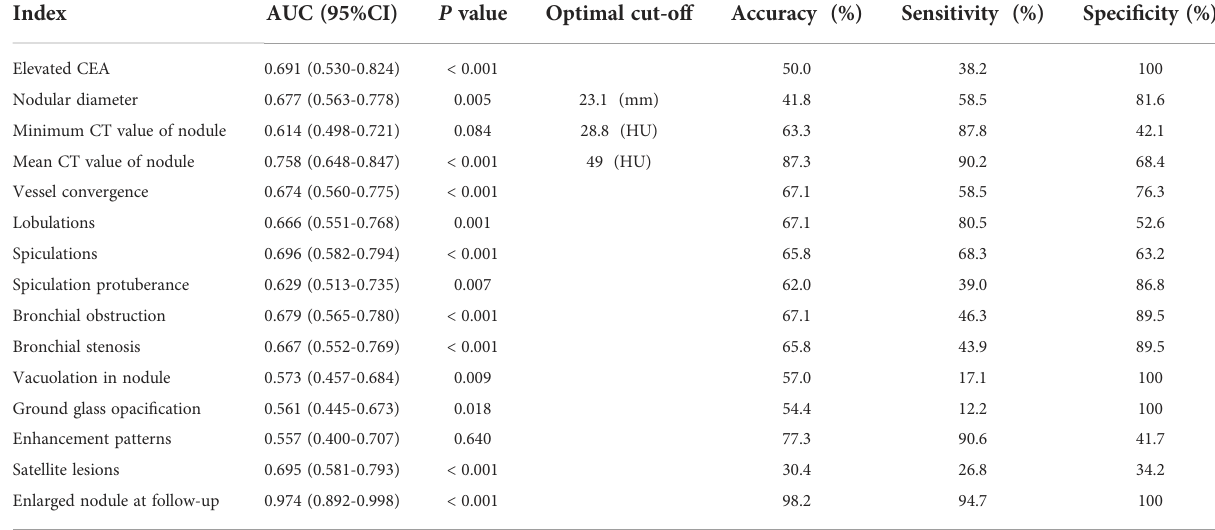
TABLE 3 Diagnostic ef fi cacy of clinical and CT features in patients with lung cancer occurrence in a lobe affected by tuberculosis and control